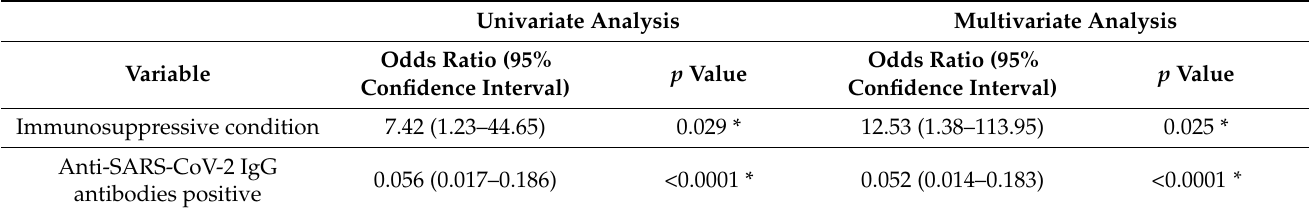
Table 2. Univariate analysis and multivariate analysis of factors associated with absence of SARS-CoV-2 Spike (S) protein and Membrane (M) protein specific T cell response in ELISpot analysis. * significant. Univariate Analysis Multivariate